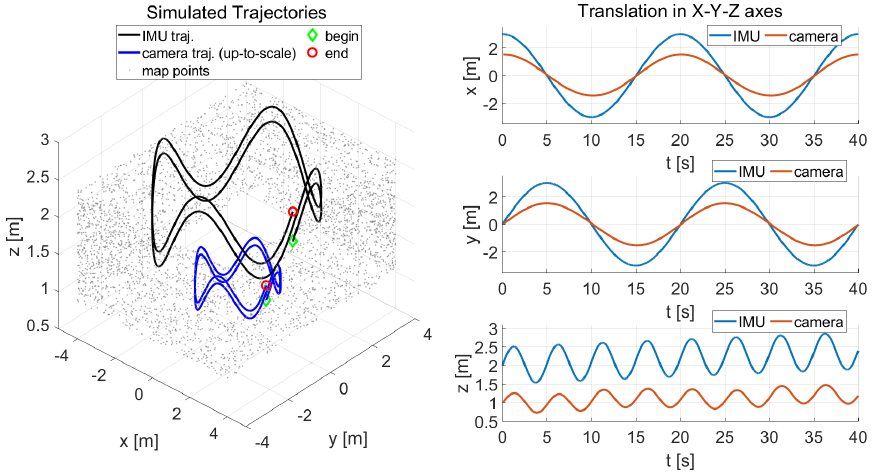
Figure 4. The left subplot shows the parametric IMU trajectory (black curve), up-to-scale camera trajectory (blue curve), and map points (gray dots). The three right subplots are the translation of the camera and IMU poses in x, y, z-axis, with a time offset of 0.1 s. The radius of the circular motion in the x-y plane is 3 m. The amplitude of the vertical sinusoidal motion in the z-axis is ( 0.5 + 0.01 · t ) m. The frequency is 0.2 Hz. The metric-scale of camera poses is customized to 2.0. The green diamond and red circle, respectively, represent the beginning and the end of the trajectory. The simulated sensor moves for 40 s; thus, the total length of the trajectory is 41.59